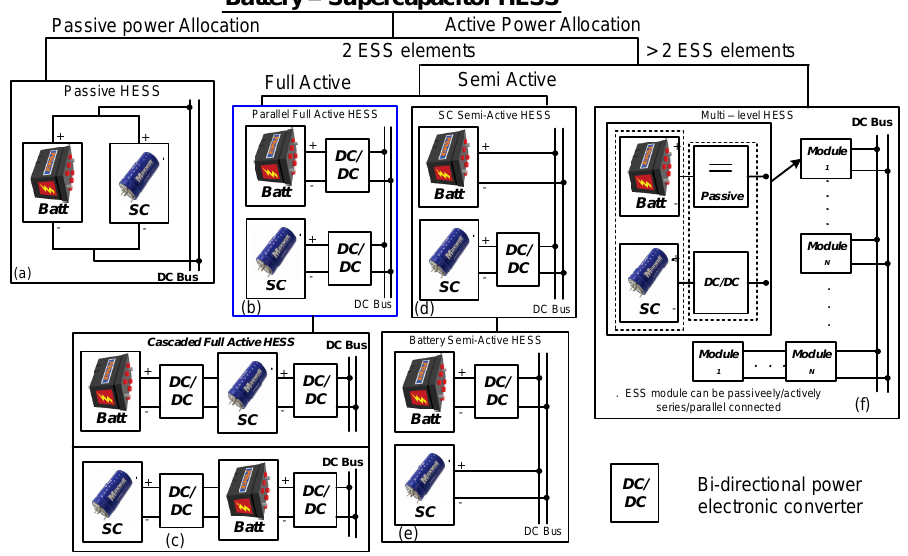
Figure 4. Classification of HESS architectures.